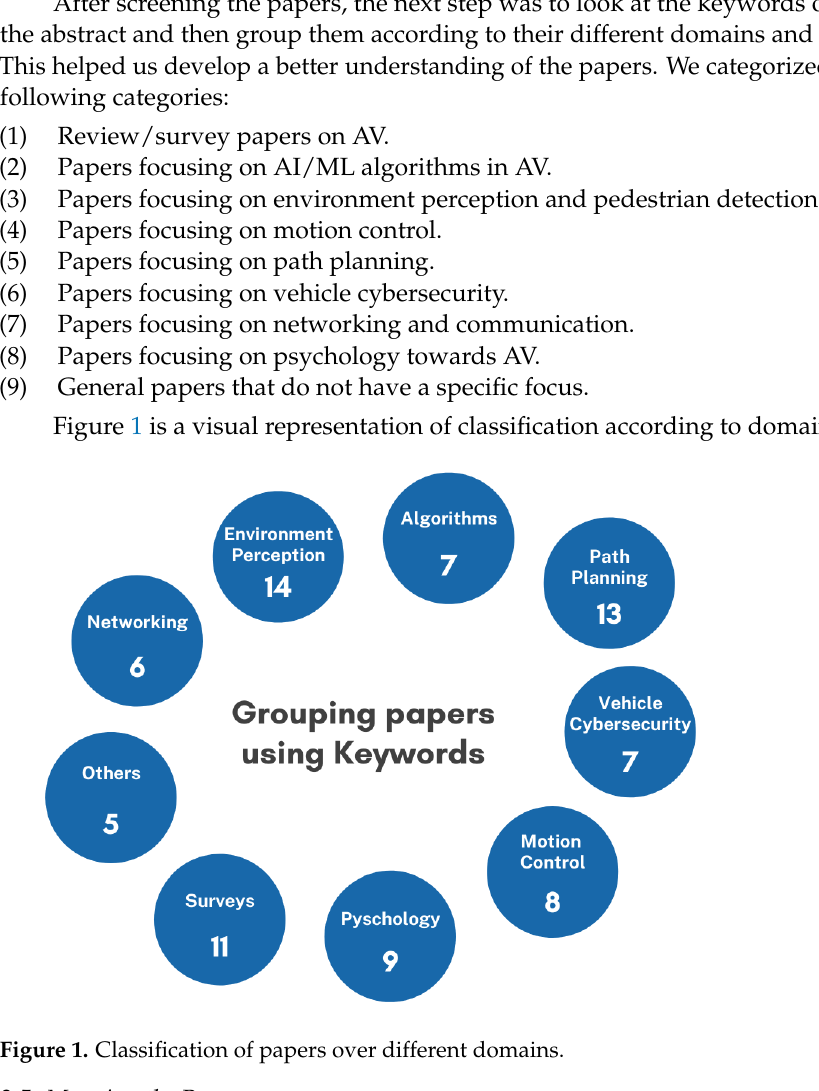
Figure 1. Classification of papers over different